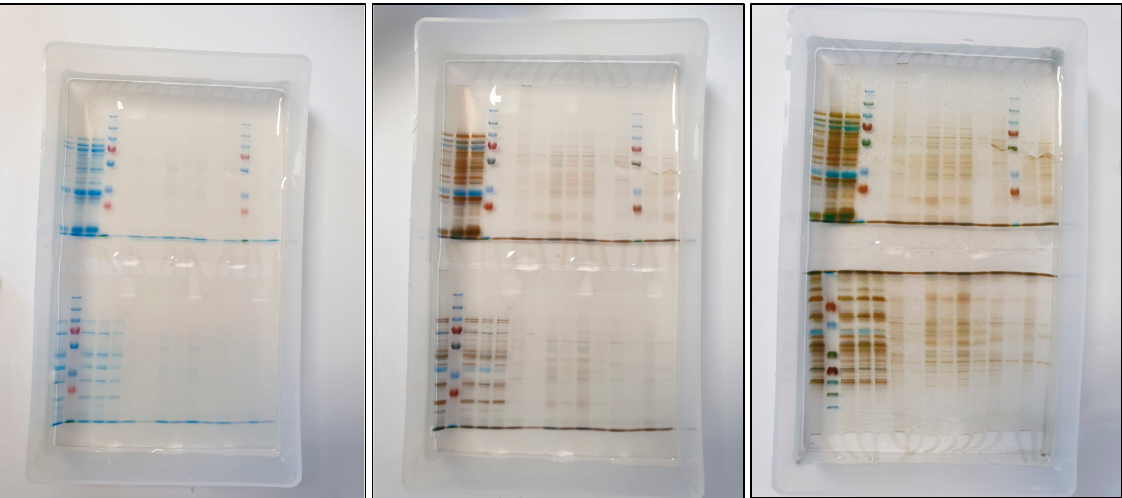
Figure 3. Polyacrylamide Gel Staining Steps Using Coomassie Brilliant Blue G-250 ® and Thermo Scientific Pierce Silver Stain ® Dye.